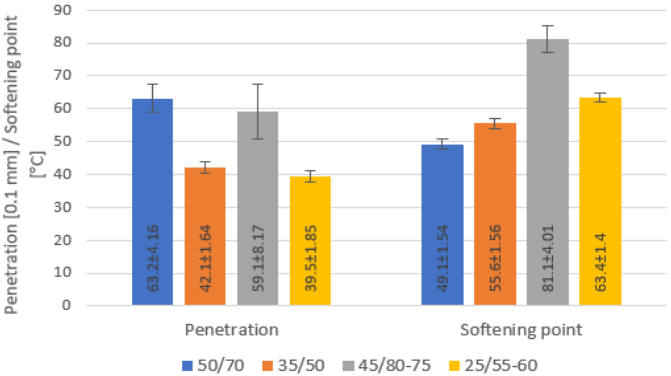
Figure 1. Penetration at 25 °C and softening point of tested bitumen samples.